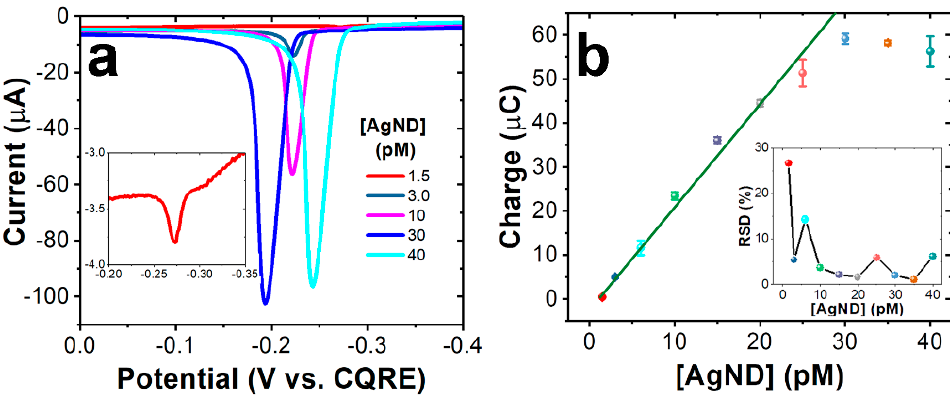
Figure 4. Detection of different concentrations of the model composites. ( a ) Representative ASVs for model composites having the concentrations indicated in the legend. The inset is an expanded view of the ASV of a sample with 1.5 pM AgNDs. ( b ) A calibration curve for the model composite. The linear range is 1.5–30.0 pM. The error bars represent the standard deviation from the mean for three independent measurements. The corresponding relative standard deviations as a function of the model composite concentration are shown inset.